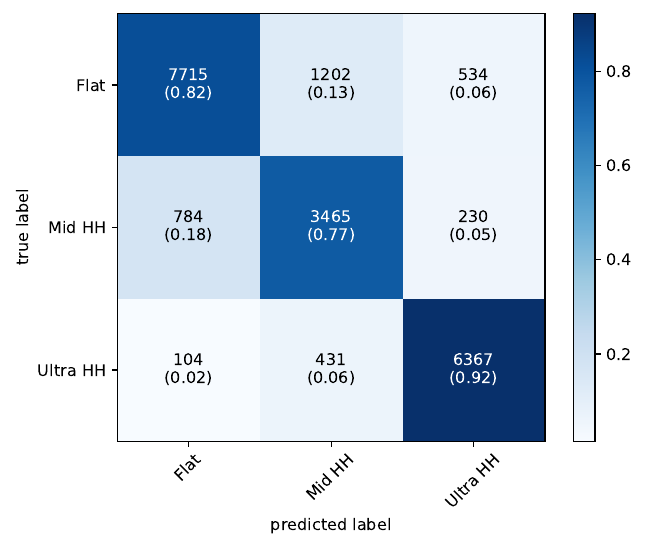
Figure 7. Confusion matrix for the proposed Sensing-HH in waist